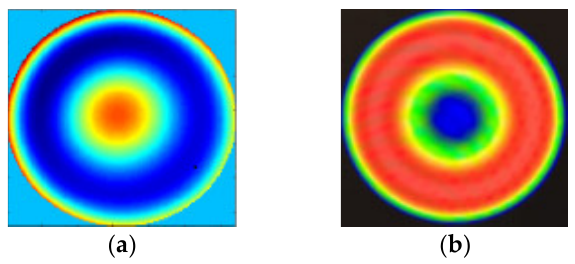
Figure 9. The measurement results with ( a ) PR: RMS = 0.674 λ , PV = 3.12 λ ; ( b ) ZYGO interferometer: RMS = 0.632 λ , PV = 2.155 λ .